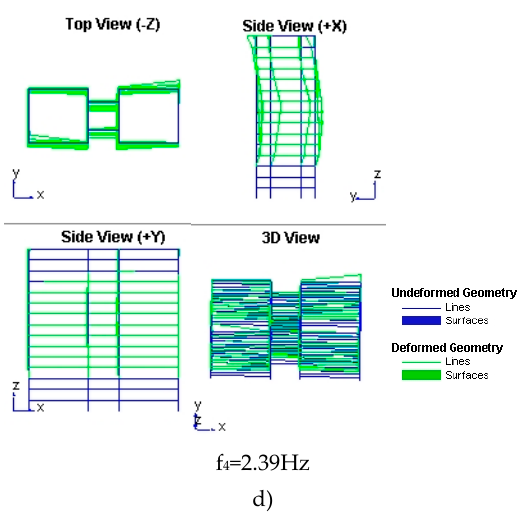
Figure 9. Ambient vibration test results: vibration modes corresponding to a ) 1 st frequency; b ) 2 nd frequency, c ) 3 rd frequency and d ) 4 th frequency.